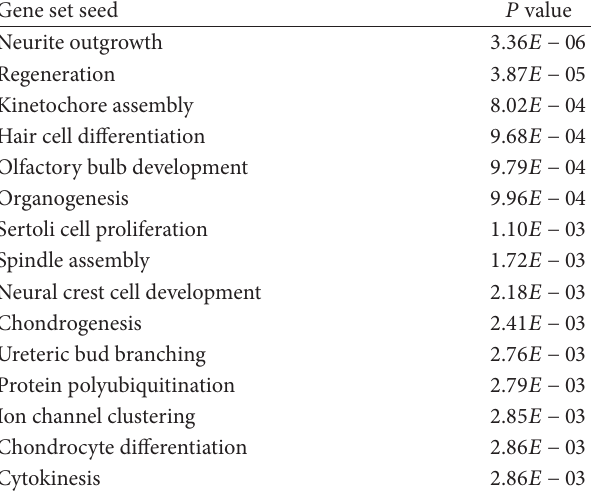
Table 2: Subnetworks of genes involved in regulating cell processes that are highly regulated between patients with poor and good